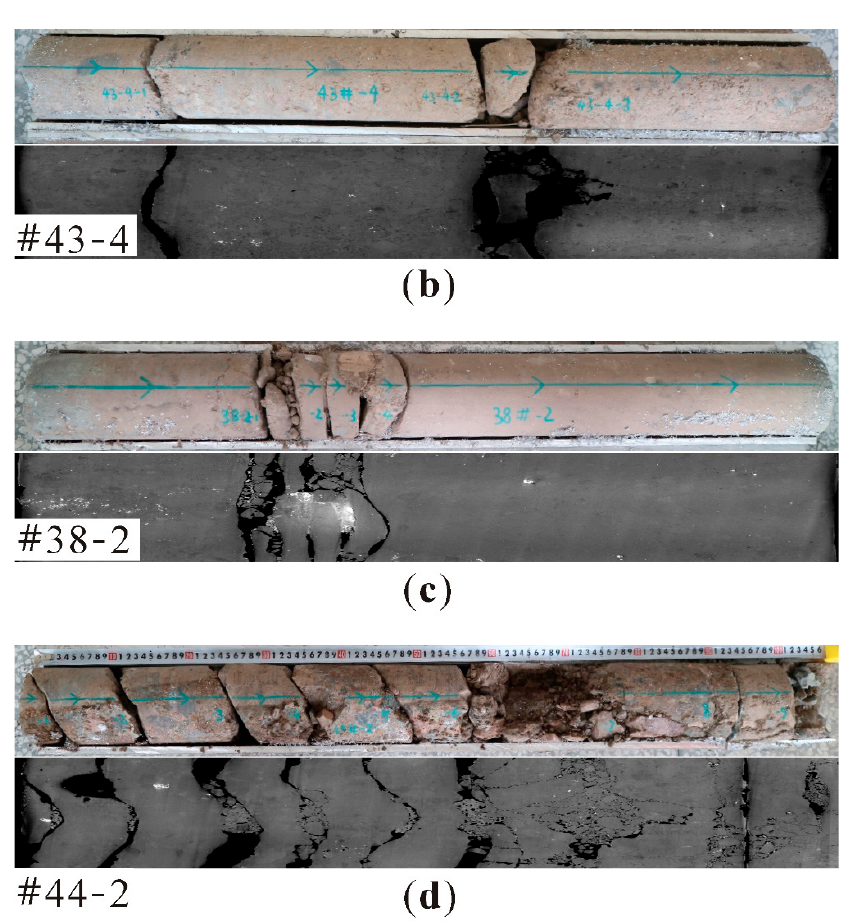
Figure 8. Fracture swarms in the slant core. ( a ) Doublets; ( b ) triplets; ( c ) 5-fracture swarm; ( d ) 9-fracture swarm.